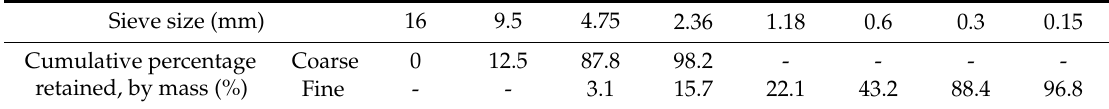
Table 2. The grain size distribution of